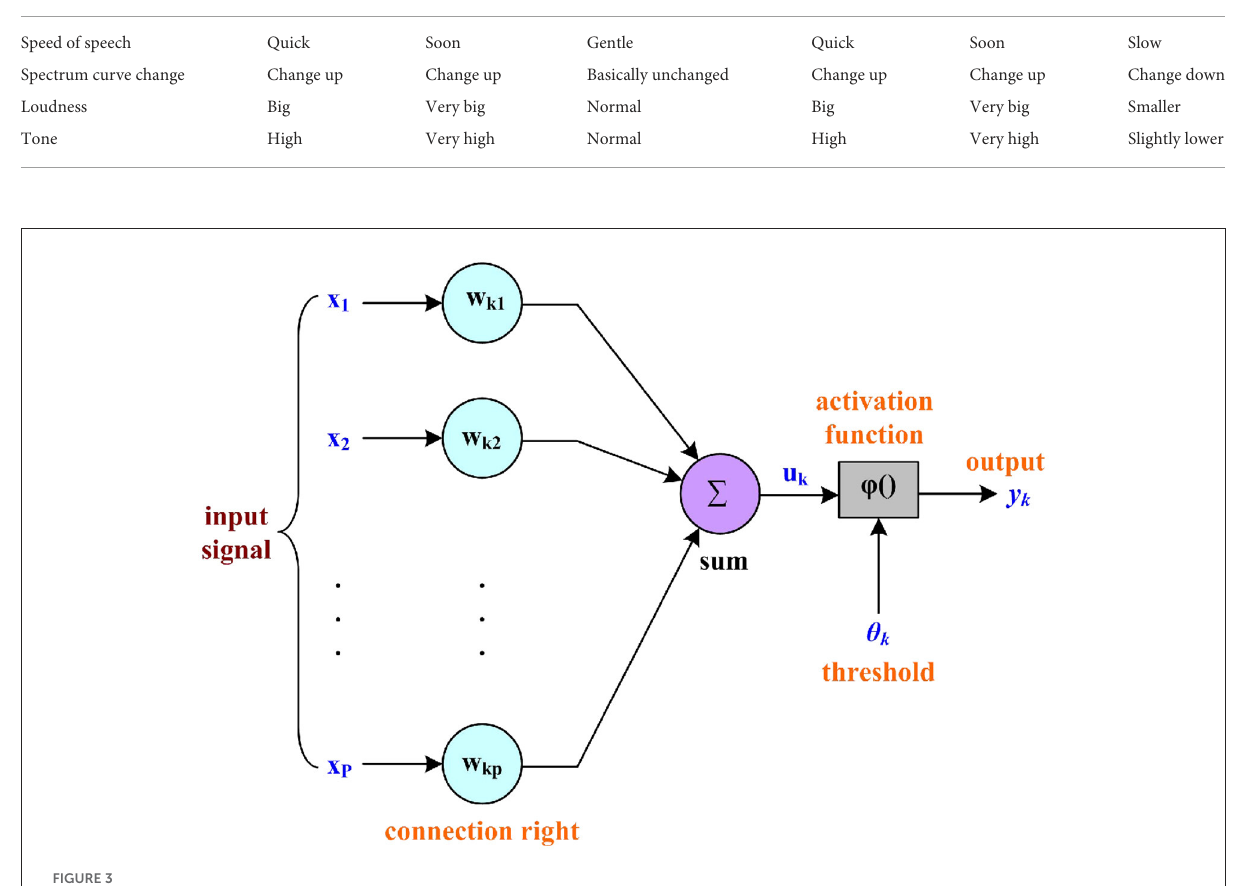
FIGURE3 Structure diagram of artificial neuron.